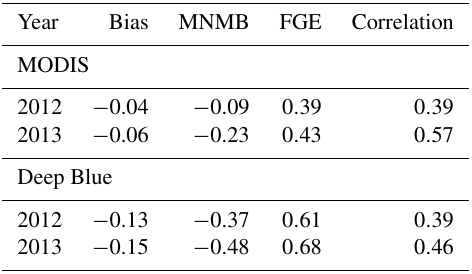
Table 1. Mean statistics of the comparison between the MODIS AOD and the MOCAGE simulation for the years 2012 and 2013. See Appendix A for information about statistical indicators.